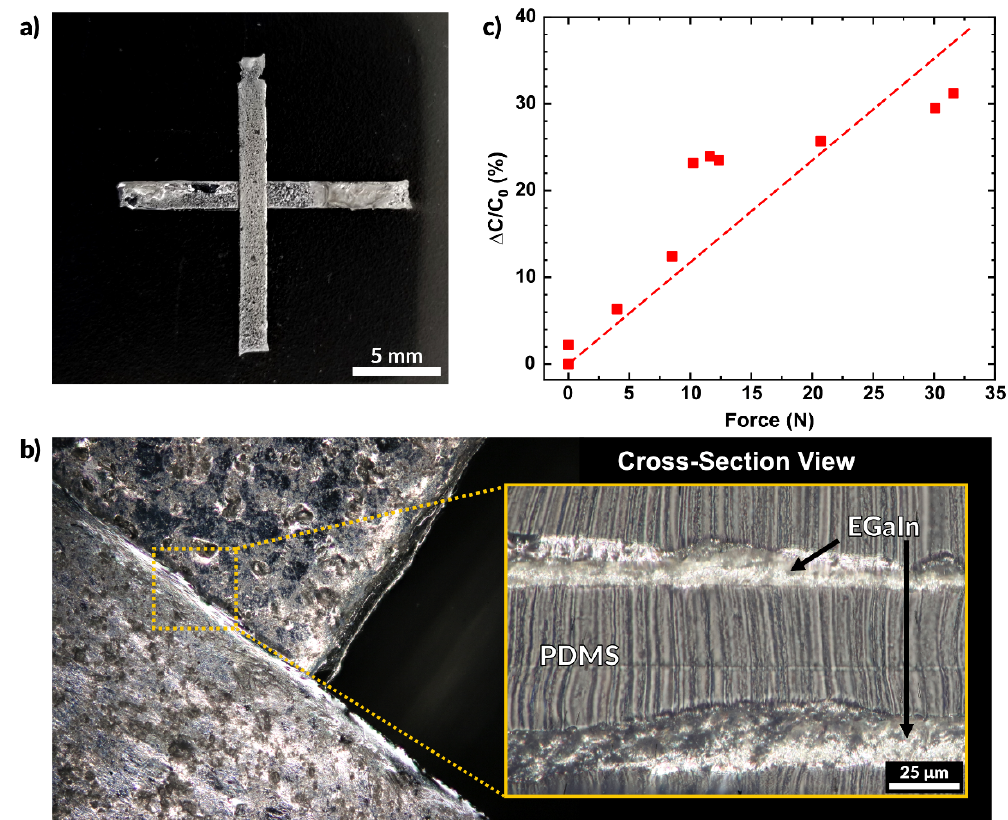
Figure 7. A capacitive sensor created entirely by aerosol spray coating. ( a ) Multilayer capacitive sensor made using liquid metal electrodes and sprayed layers of PDMS. ( b ) Overhead view of the overlap of the two electrodes and a cross-sectional view of the electrodes separated by a layer of sprayed PDMS. ( c ) Plot of the measured change in capacitance as a function of force.